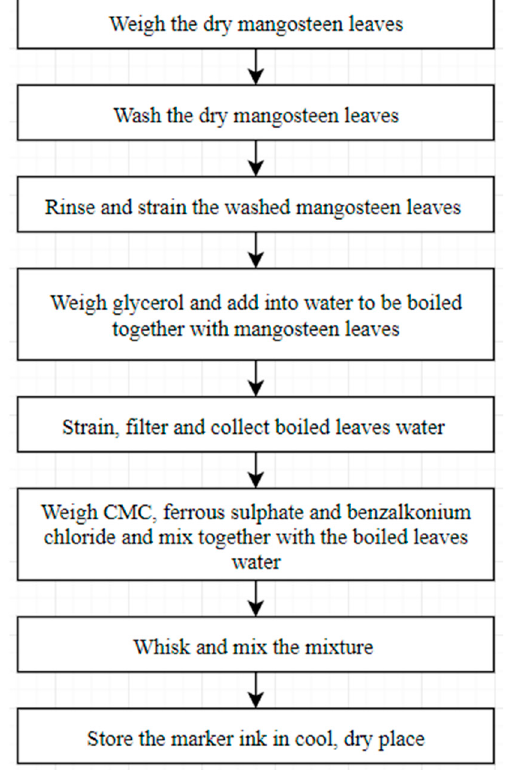
Figure 1. Fabrication process of mangosteen-leaves-based marker ink.